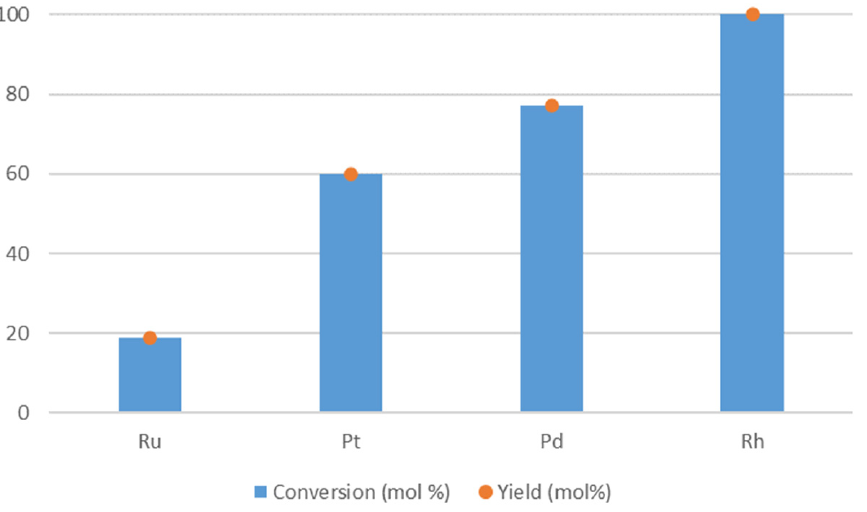
Figure 2. The conversion (mol%, blue) and yield (mol%, orange) of the hydrogenation reactions of maleic acid in presence of Ru, Pt, Pd and Rh NPs (metal = 0.037 mM) in water at room temperature and pressure with H 2 after 8 h of reaction.